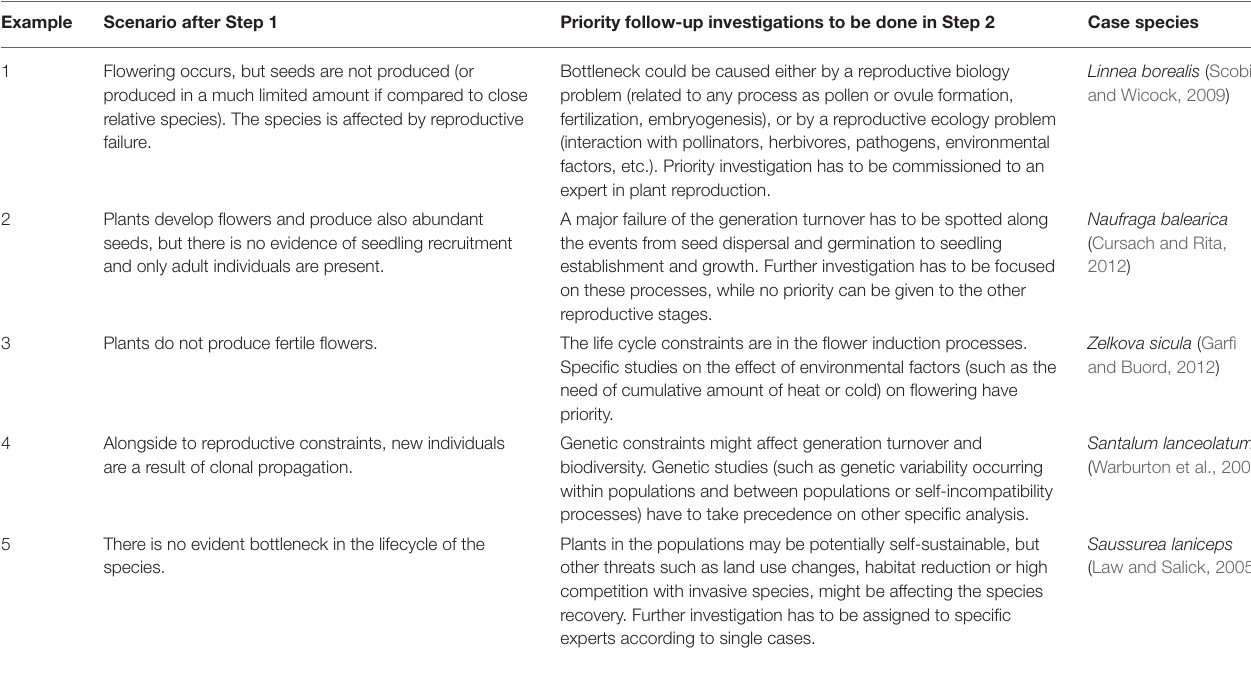
TABLE 1 | Illustrative examples of (a) possible scenarios after Step 1, (b) indication for priority follow-up activities in Step 2 and (c) single case species whose bottleneck is reported in literature.